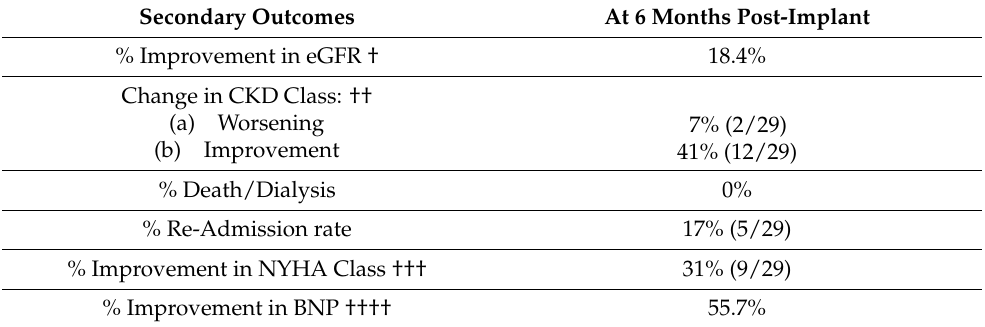
Table 3. Secondary outcomes